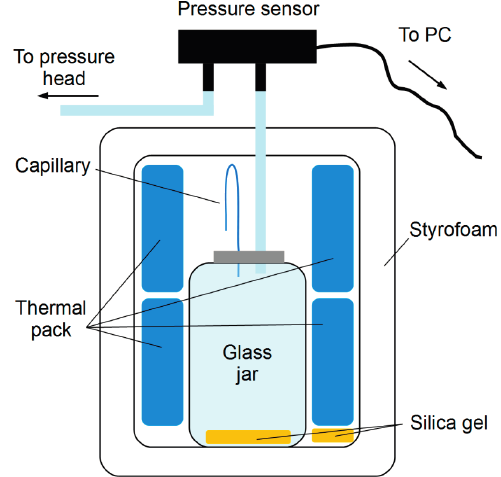
Figure 2. Schematic picture of the pressure sensor and the pressure